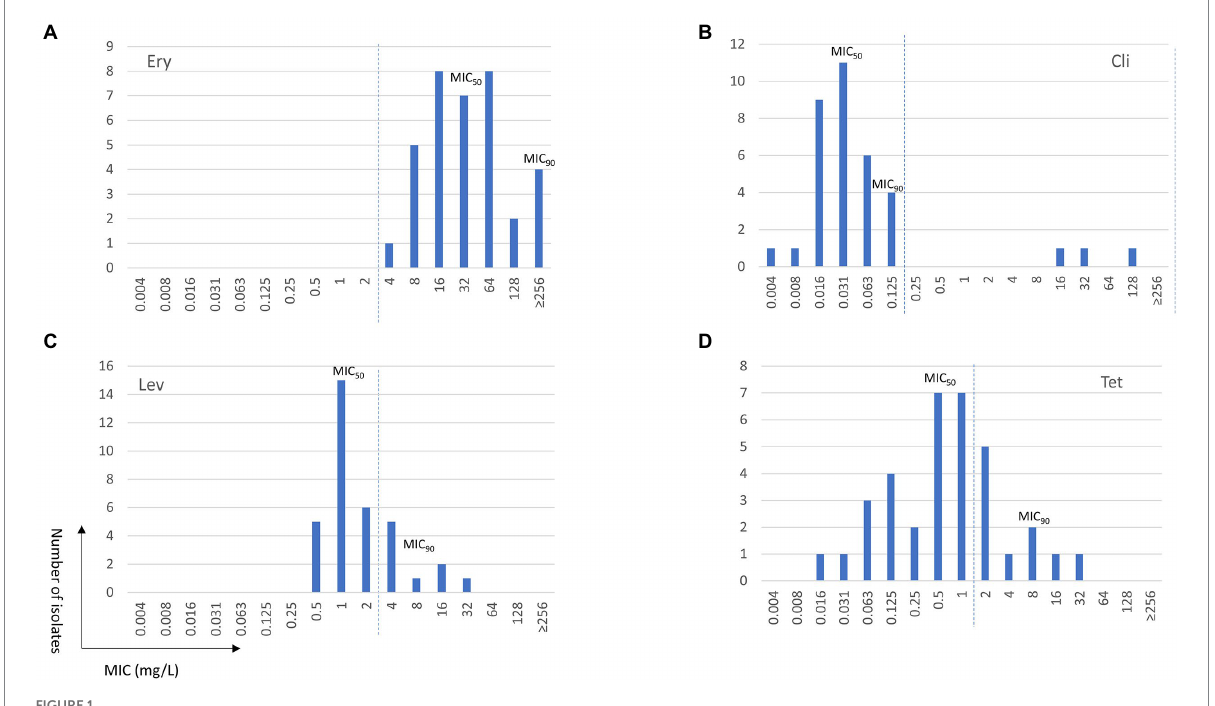
FIGURE 1 Minimum inhibition concentration (MIC) distributions of erythromycin (Ery, A ), clindamycin (Cli, B ), levofloxacin (Lev, C ), and tetracycline (Tet, D ) for Mycoplasma salivarium isolates. The dashed line divides the cutoff values for wild type (left) and mutant (right)